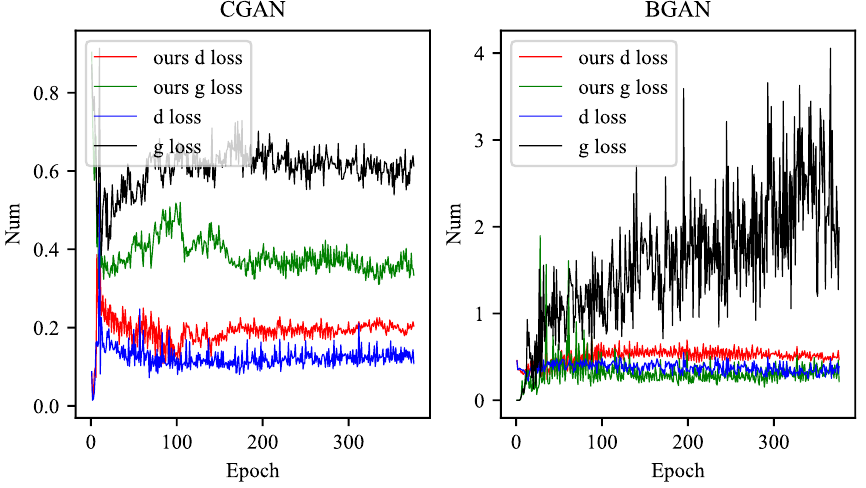
Figure 3. The results of the CGAN [31] and BGAN [36] model.